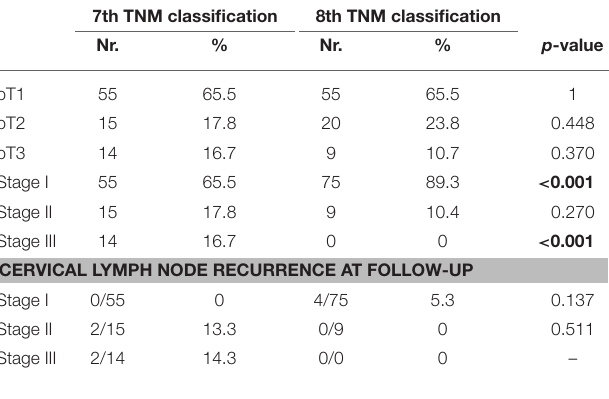
TABLE 2 | Tumor characteristics according to the 7 and 8th edition of TNM and data about